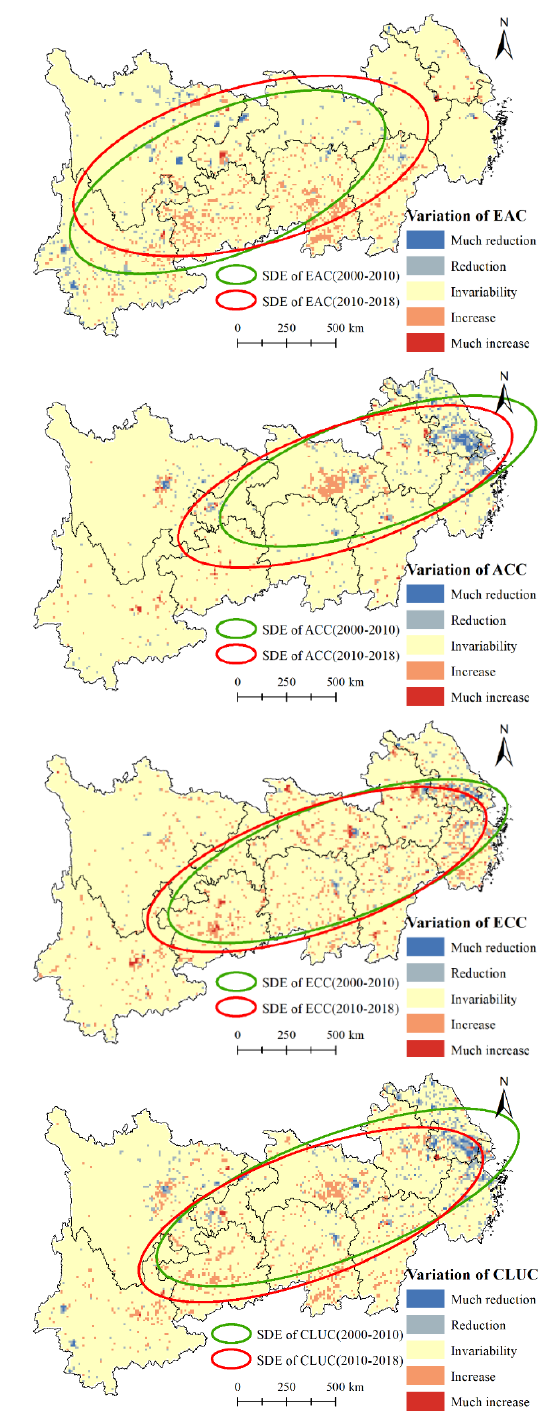
Figure 5. Variation and standard deviation ellipse (SDEs) during study periods of land use conflict indicators.